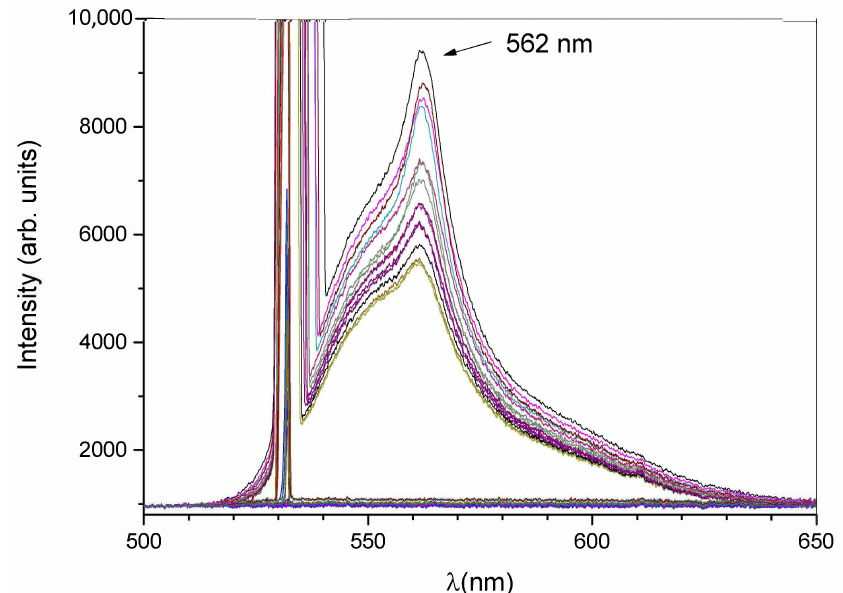
Figure 3. The ASE effect is observed by pumping the free-standing film outside the grating area. The peak on the left side is due to the pumping beam. The wide peak on the right side has a full width at half maximum (FWHM) of about 5 nm and is due to the presence of the R6G dye. The range of fluences used is 10–80 mJ/cm 2 , the ASE threshold is located at ≈ 15 mJ/cm 2 . Irradiation wavelength λ = 532 nm, pulse duration τ = 4